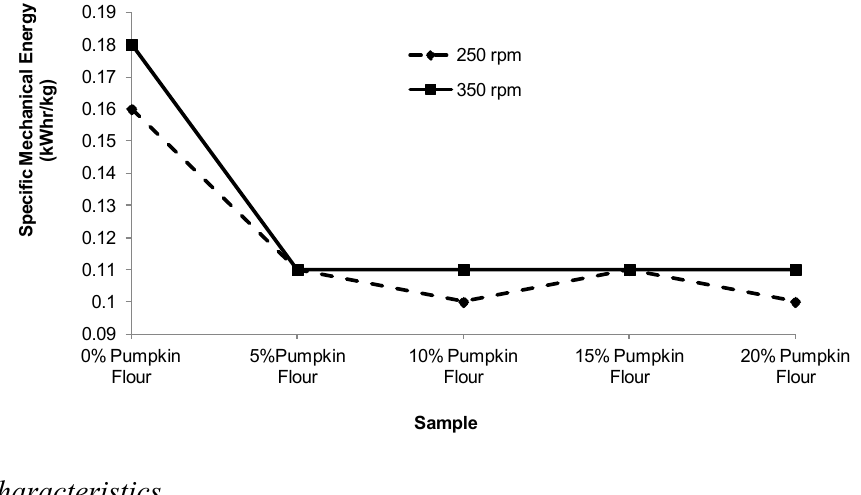
Figure 3. Effect of screw speed and the proportion of pumpkin flour on the specific mechanical energy (SME (kWh/kg)). Each value was an average of duplicate samples.